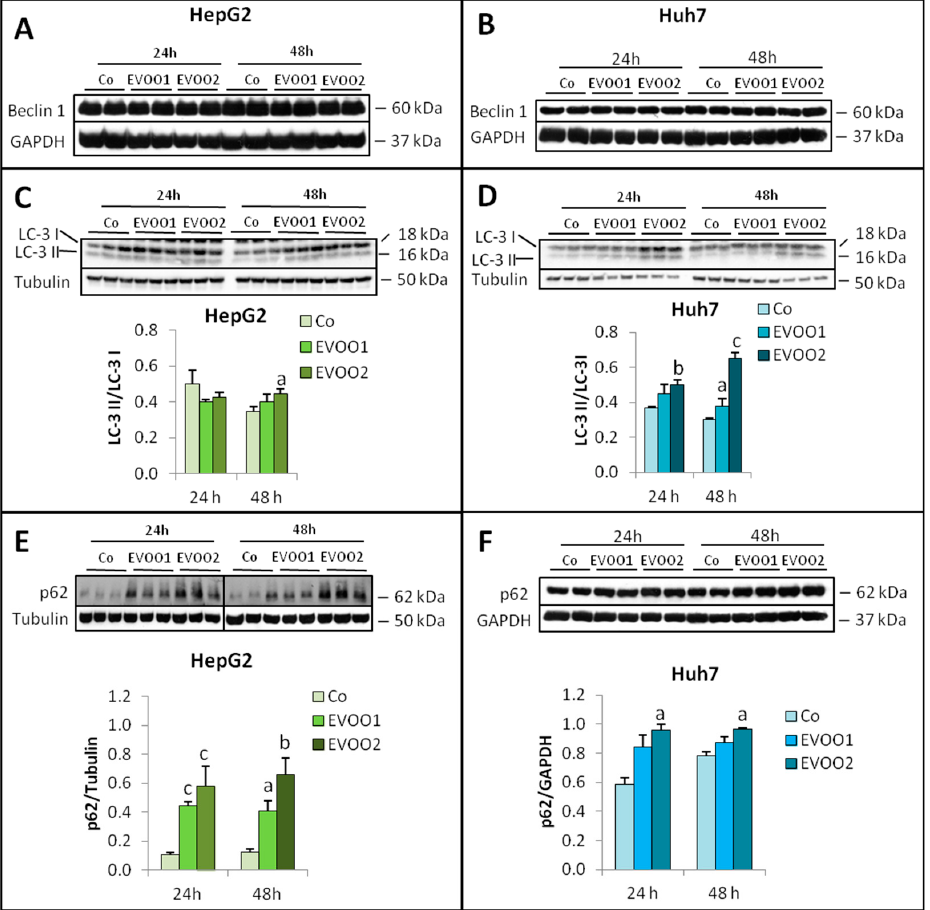
Figure 7. Phenolic extract modulates the expression of proteins involved in autophagy. The cells were incubated for 24 and 48 h with two different doses of the EVOO extract. ( A , C , E ) Expression of Beclin 1, LC-3 and p62 in HepG2 cell line. ( B , D , F ) Expression of Beclin 1, LC-3 and p62 in Huh7 cell line. The results are representative of three experiments. The protein molecular weights are reported. Data are presented as mean ± SD. (a: p < 0.05, b: p < 0.01, c: p < 0.001 versus Control).